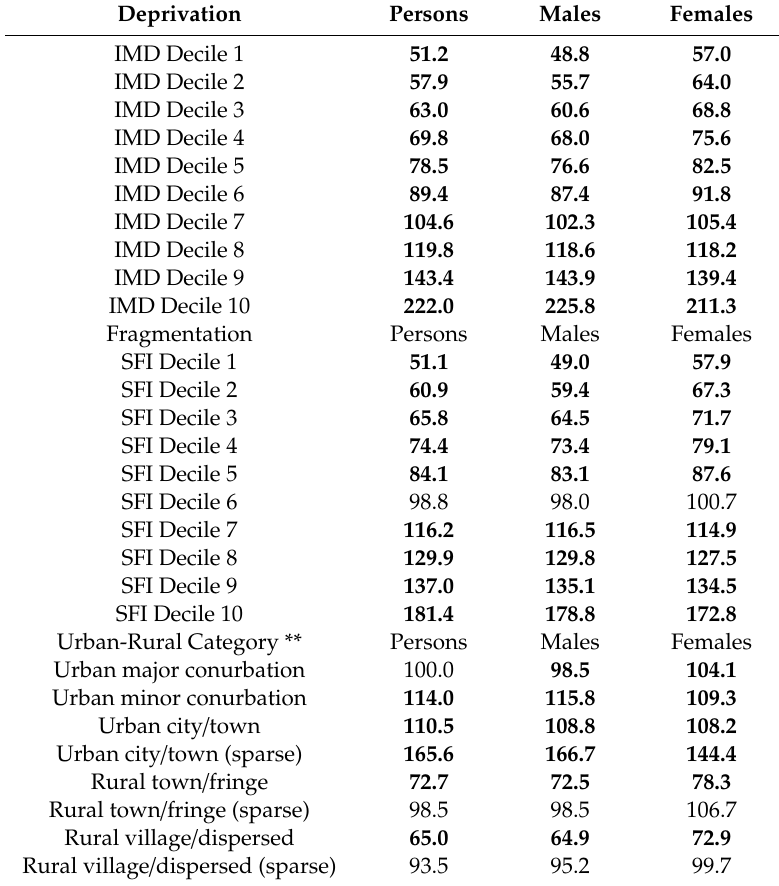
Table 5. Estimated Standard Mortality Ratios, Drug Related Deaths